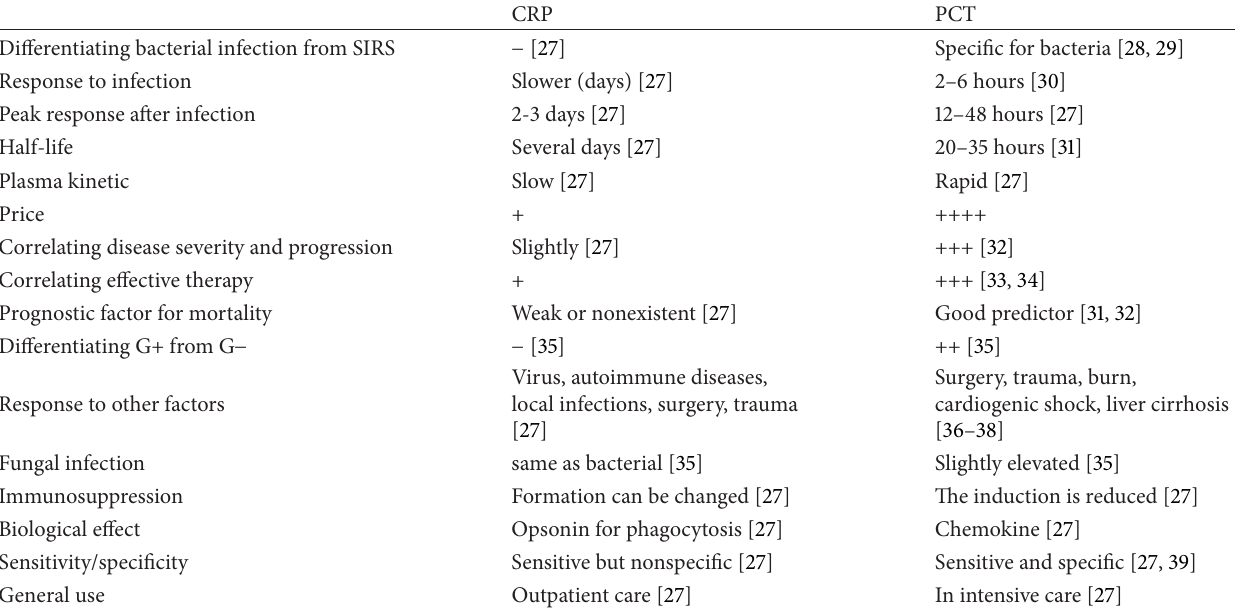
Table 1: Comparison of CRP versus PCT (advantages and